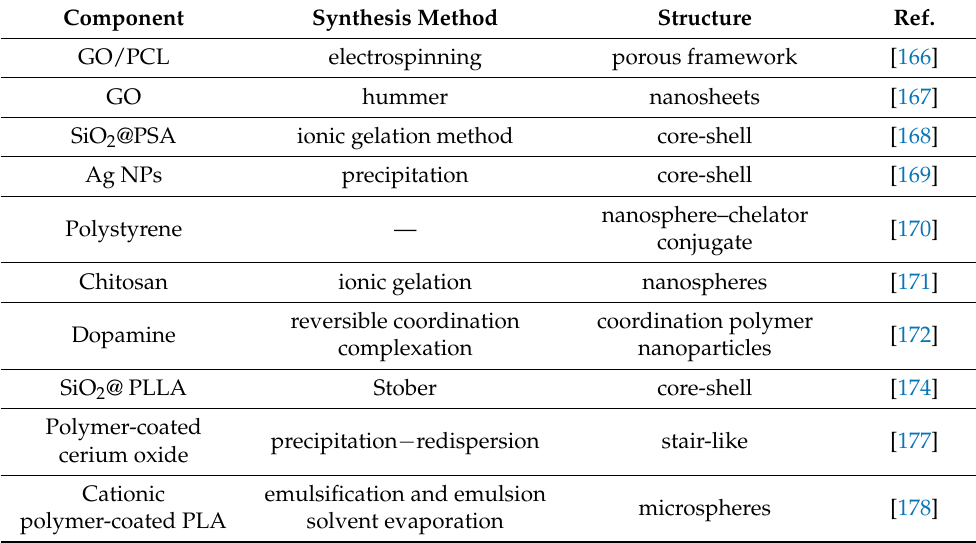
Table 2. The structure and synthesis method of the coated